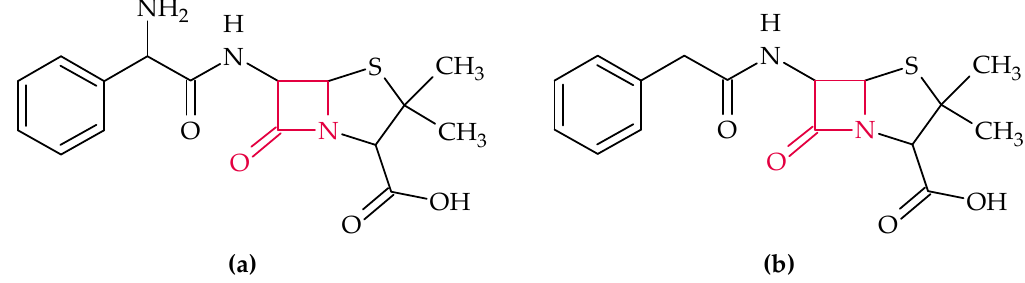
Figure 2. Chemical structure of: ( a ) ampicillin and ( b ) penicillin G. The β -lactam ring is marked in red.